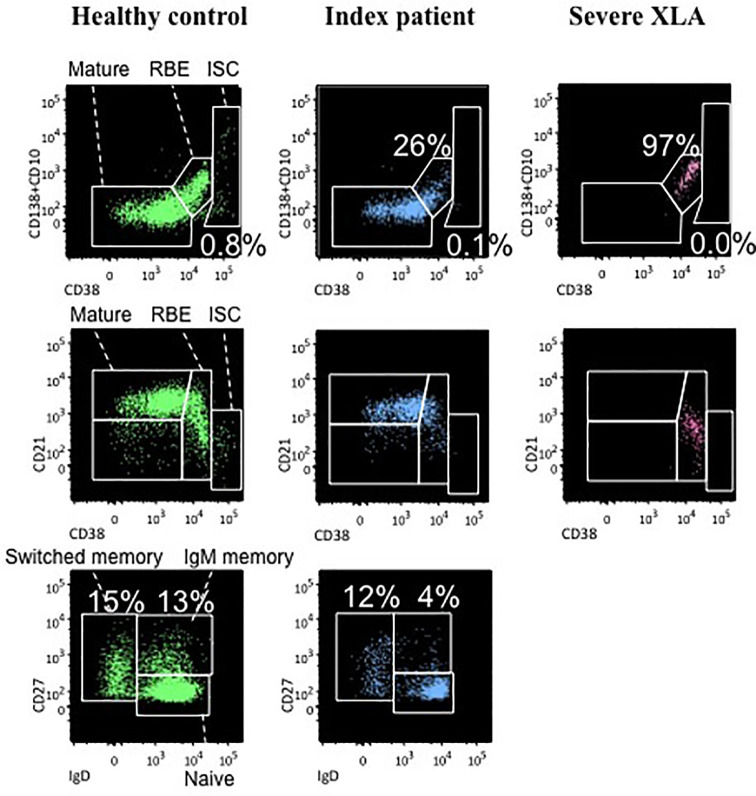
Analysis of peripheral B cell subset distribution a healthy control (left column), the index patient (central column), and a severe XLA patient (right column). For each subject the following B cell subsets are presented: recent bone marrow emigrants (RBE) (CD20+CD38++CD10+), immunoglobulin-secreting cells (ISC) (CD38+++CD27++CD20-) and mature cells (CD20+CD38+/-CD10-) which are further classified in naïve cells (IgD+IgM+CD27-) and both switched memory (IgD-IgM-CD27+) and unswitched memory cells (IgD+IgM+CD27+).